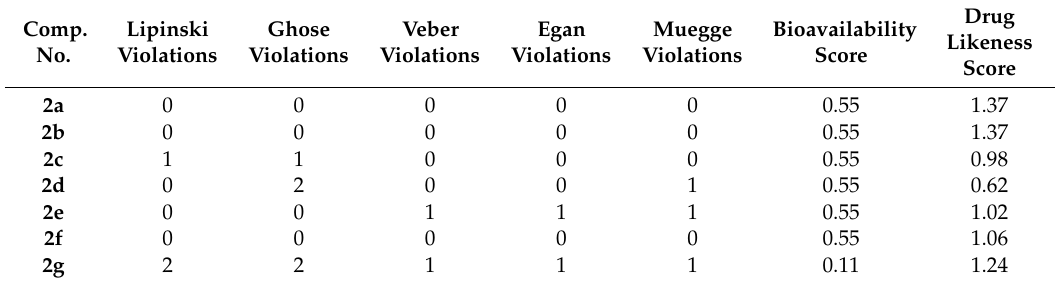
Table 4. Drug likeness predictions of the selected compounds 2a – 2g